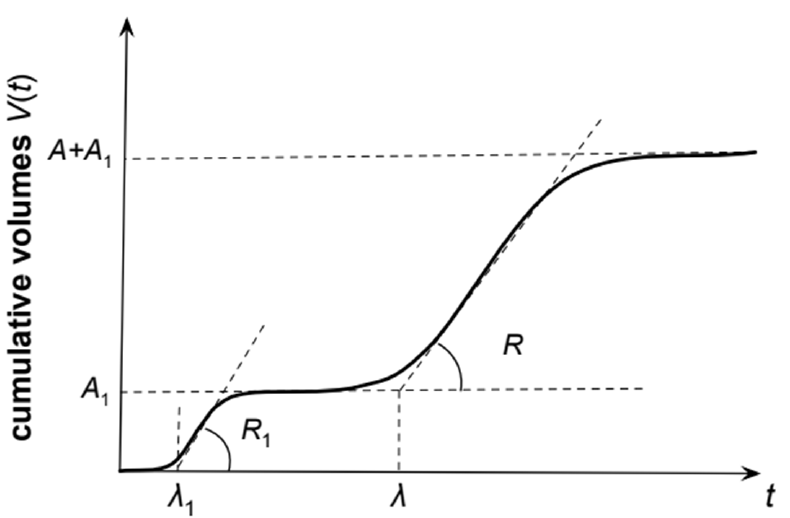
Figure 1. Biogas production in a double phase AD. Model parameters: λ 1 , λ lag times (d), R 1 , R maximum volumetric production rates (mL d − 1 ), A 1 and A asymptotic cumulative volumes (mL). Data regression was performed using the R statistical software v.4.2.2 [32] with the nlstools package v.2.0.0